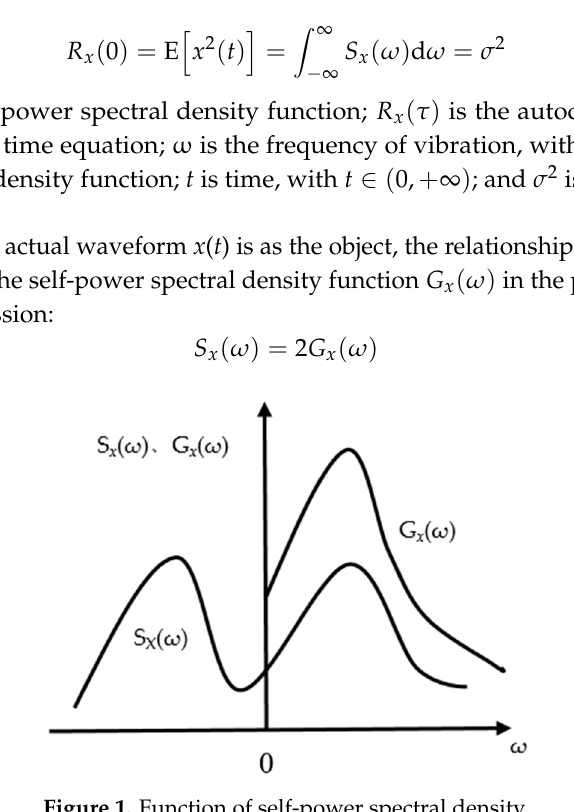
Figure 1. Function of self-power spectral density.